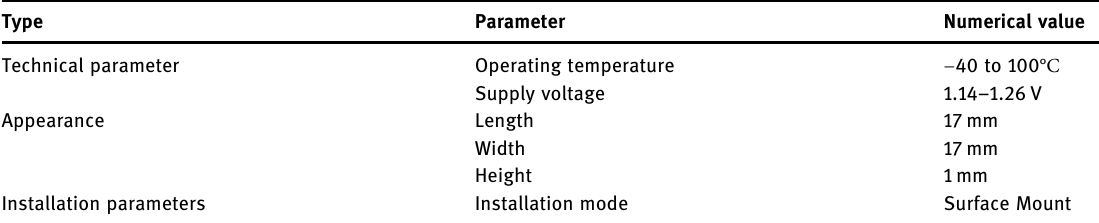
Table 1: Spartan - 3E XC3S500E basic